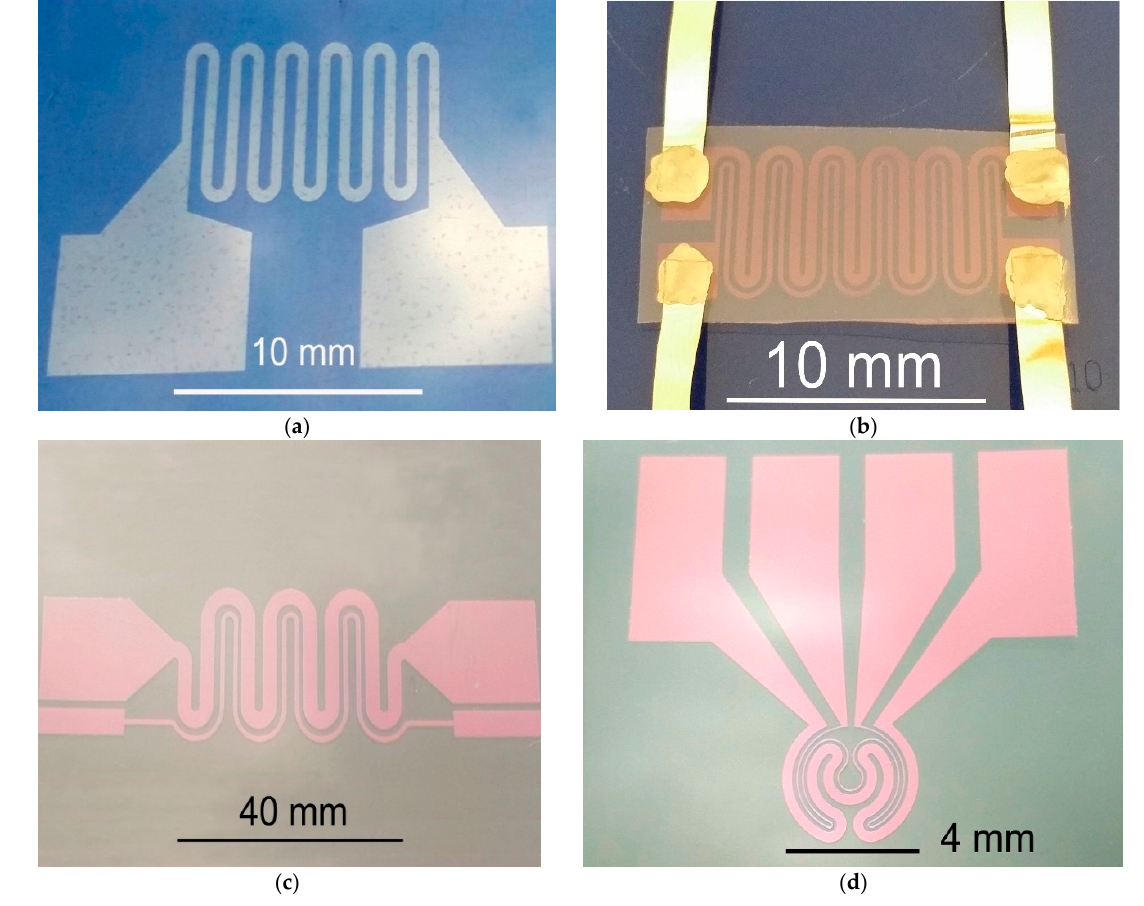
Figure 1. Samples of structures made by direct laser patterning in indium tin oxide (ITO) and ITO/Ag/ITO layers: ( a ) meander shaped resistor (ITO layer on PET); ( b ) resistor with thermosensor (ITO/Ag/ITO layer on PET); ( c ) resistor with thermosensor—“long” (ITO/Ag/ITO layer on PET); ( d ) microheater with sensor (ITO/Ag/ITO layer on PET).